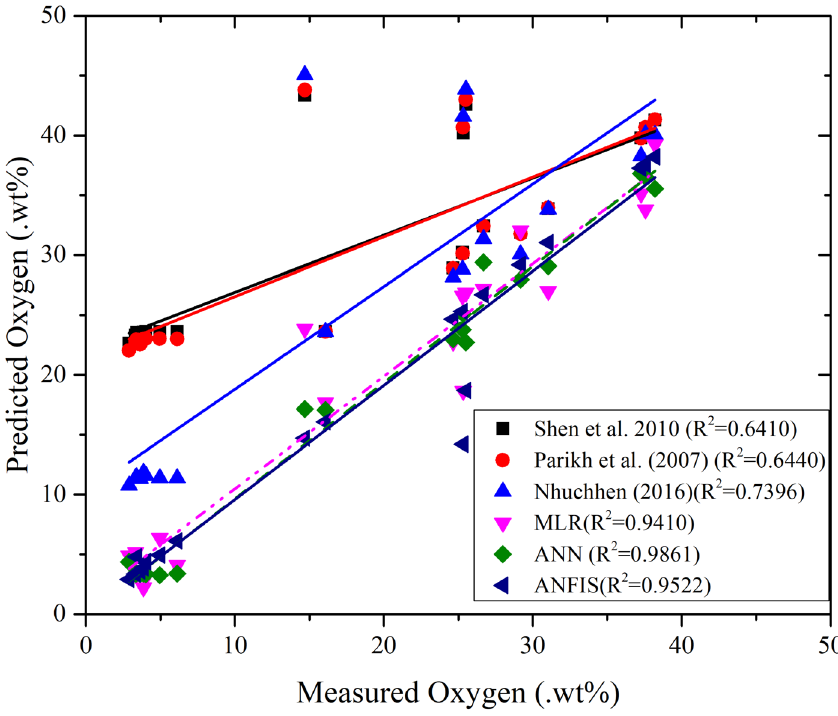
Fig. 10 Comparison of the predicted O with the measured oxygen Table 4 Adopted models for the validations of the proposed models S/N Existing model